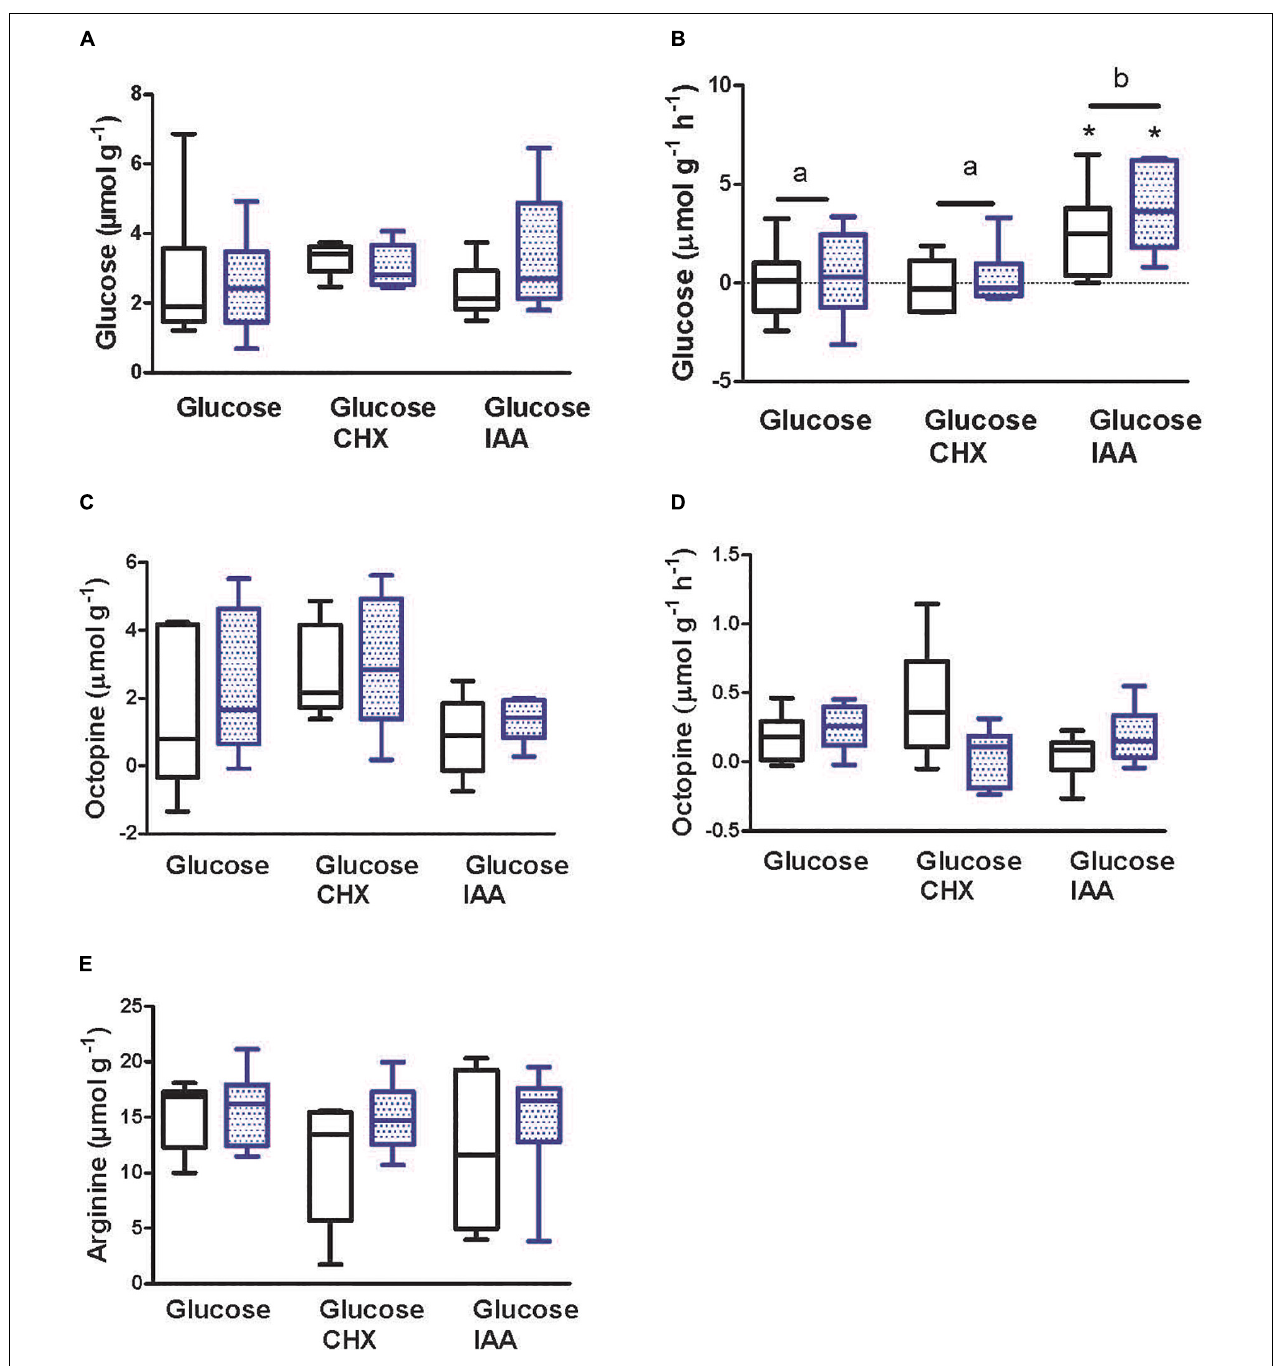
FIGURE 4 | Glucose, octopine, and arginine levels following 1 h recovery from intense contractility. One of two paired mantle muscle sheets from cuttlefish ( Sepia officinalis ) was stimulated to contract for 30 s at 3 Hz simulating jetting behavior. (A,C,E) tissue concentrations after a 1 h period following contraction. (B,D) rate of uptake or release of metabolite into the bathing medium during the 1 h period following contraction. Open bars represent unstimulated preparations; stippled bars indicate preparations that were stimulated. Text below x -axis shows additions to media. For CHX and IAA additions, preparations were incubated for 10 min prior to stimulation, during stimulation, and throughout the post contraction incubation period. N = 6 under all conditions except tissue glucose in stimulated preparations incubated with CHX, tissue octopine in unstimulated preparations incubated with CHX, and media glucose in unstimulated preparations incubated with IAA where N = 5. Values with different letters are significantly different. ∗ Significant difference from zero (one sample t -test) for rate of glucose appearance in bathing medium. Box and whisker plots show the range and median value.